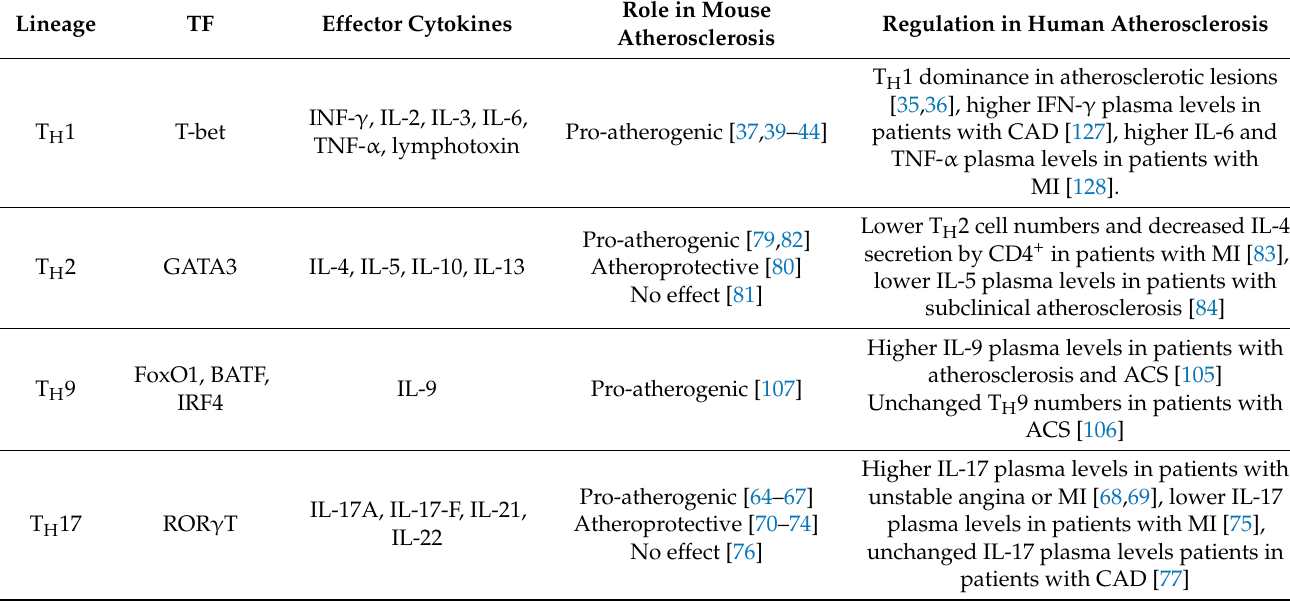
Table 1. CD4 + T cell subsets and functions in